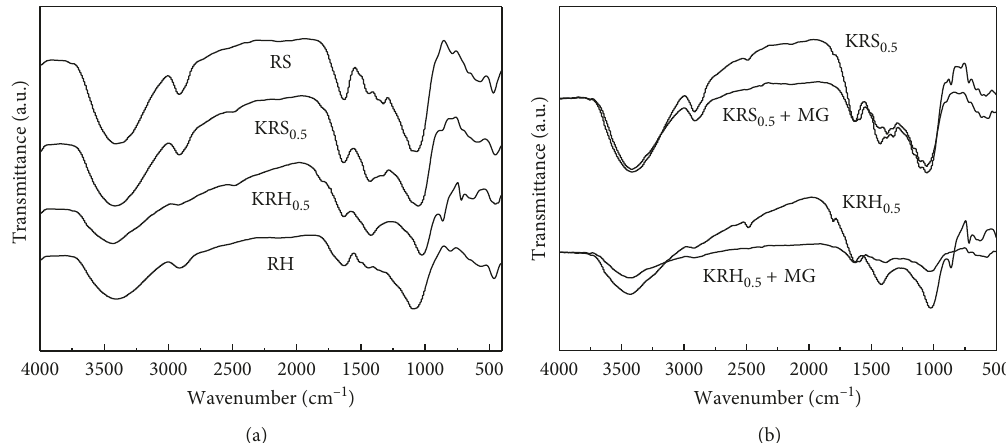
Figure 2: (a) The FT-IR spectra of RH, KRH 0.5 , RS, and KRS 0.5 . (b) The FT-IR spectra of KRH 0.5 and KRS 0.5 before and after MG adsorption.